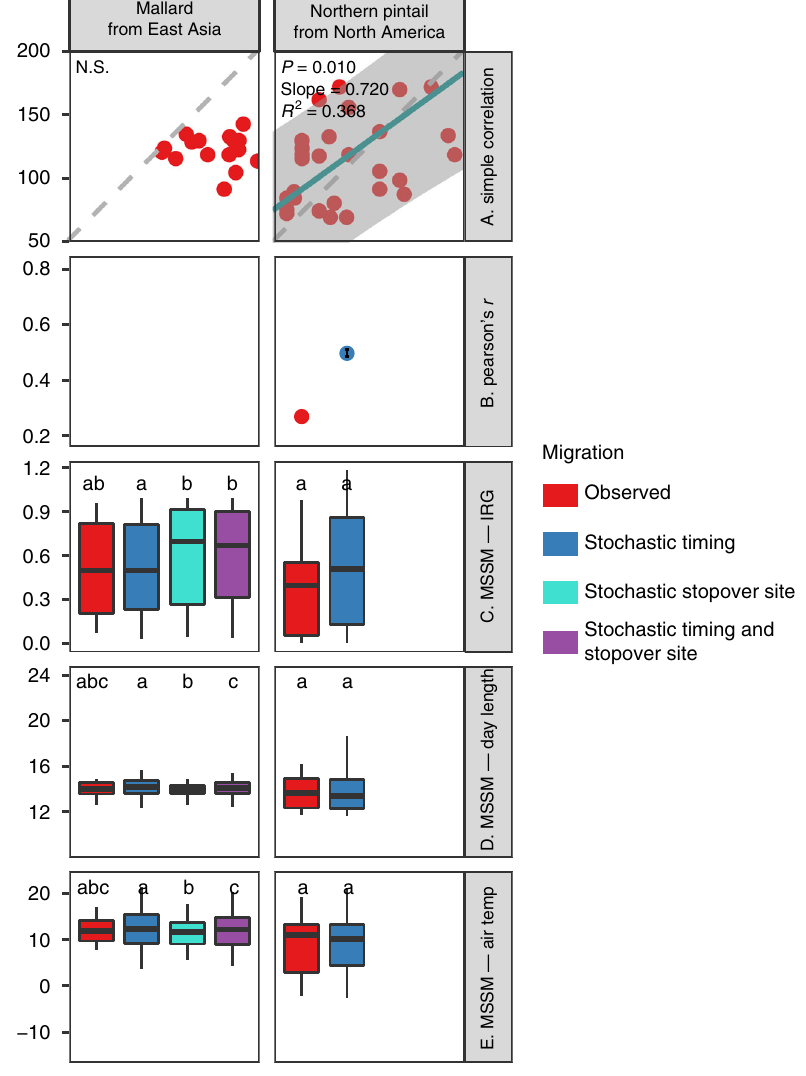
Fig. 4 Testing the green wave hypothesis for omnivores by three different methods. See Fig. 2 for de fi nitions and details of panels, symbols, colours, acronyms and boxplots. For the population without available migration tracks (Northern Pintail from North America), only stochastic timing simulations were performed, compared and plotted. Source data are provided as a Source Data fi